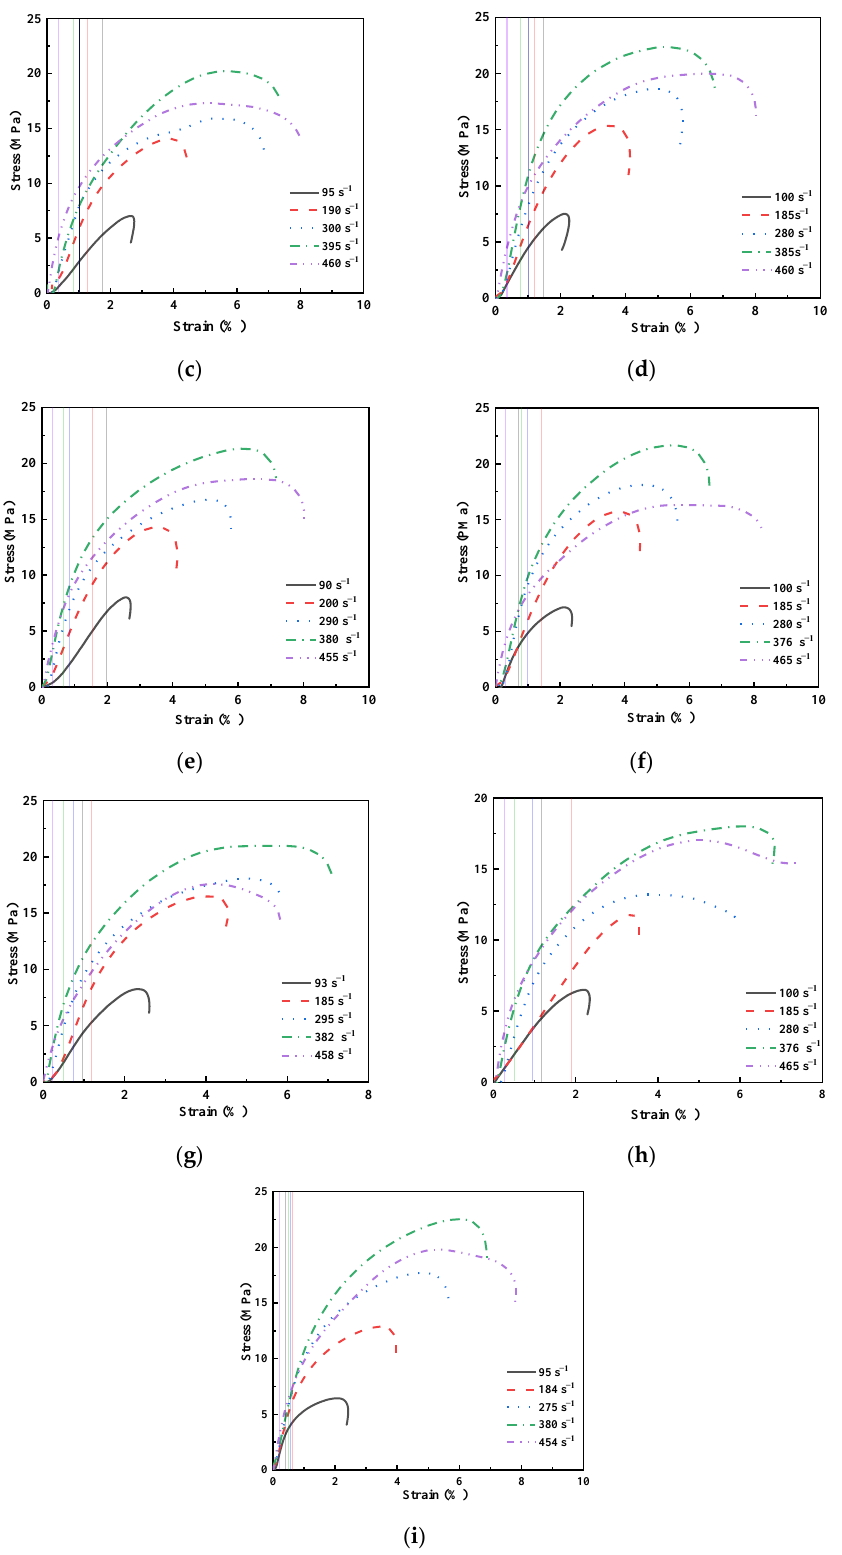
Figure 16. Dynamic stress–strain curves of sand specimens at different strain rates. The color of the vertical line corresponds to that of the strain rate. ( a ) w = 0, D r = 0.1. ( b ) w = 0, D r = 0.5. ( c ) w = 0, D r = 0.9. ( d ) w = 2%, D r = 0.9. ( e ) w = 4%, D r = 0.9. ( f ) w = 6%, D r = 0.9. ( g ) w = 8%, D r = 0.9. ( h ) w = 10%, D r = 0.9. ( i ) w = 12%, D r =